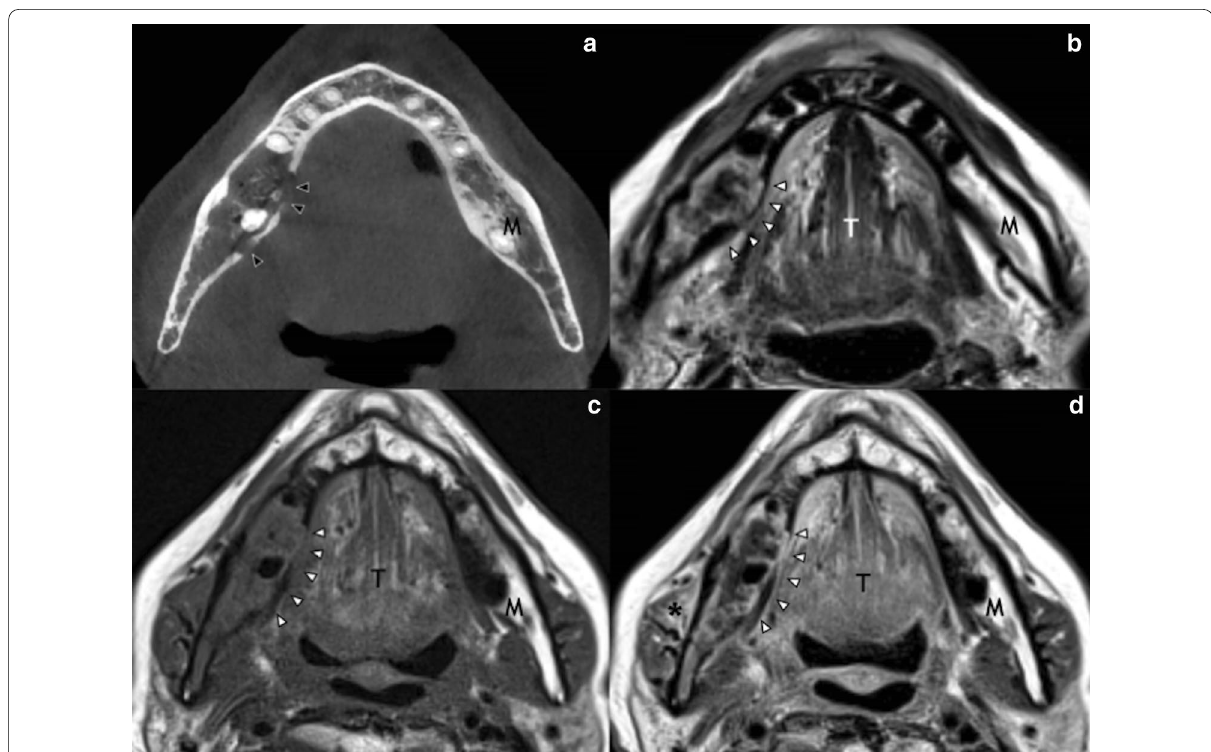
Fig. 10 Osteoradionecrosis of the right ramus of the mandible in a 70-year-old woman 4 years after ChT/RT for a right palatine tonsil cancer. Axial CT image ( a ) shows the loss of spongiosa trabeculation and several cortical breakings (black arrowheads) of the right ramus of the mandible. The corresponding MR slice of the same area (white arrowheads) shows heterogeneous and slightly hyperintense signal on axial T2-weighted ( b ), with low signal on axial T1-weighted ( c ), and subtle but diffuse enhancement in the bone and adjacent soft tissues, like the right masseter muscle (asterisk), in post-contrast axial T1-weighted image ( d ). M, mandible; T,